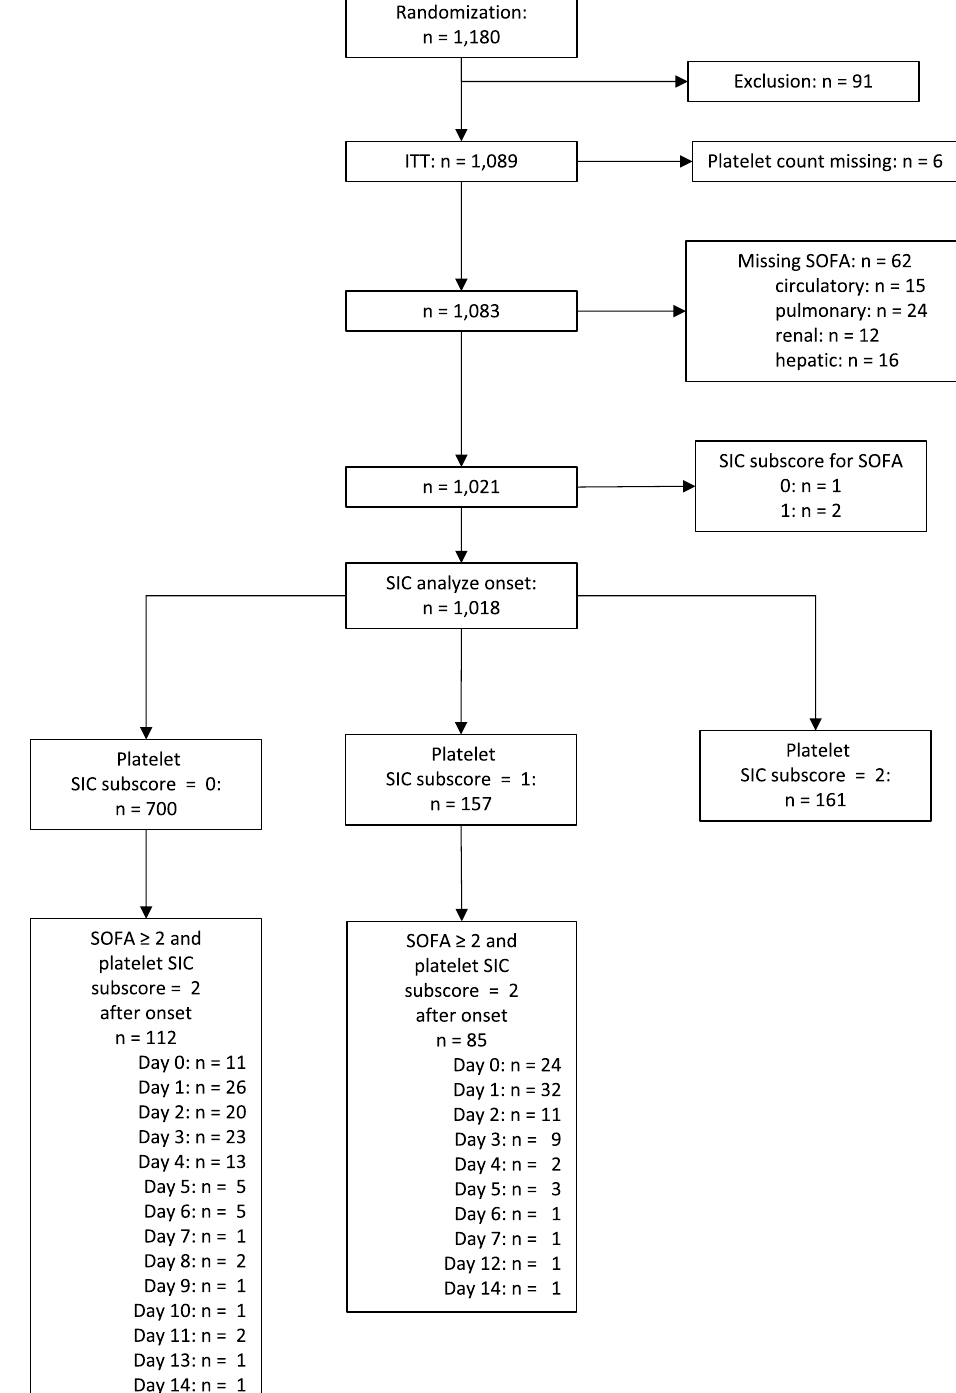
Fig. 3 Flow diagram detailing the selection of patient groups analyzed from the SISPCT trial [15]. ITT intention to treat, SIC sepsis-induced coagulopathy; SOFA Sequential (sepsis-related) Organ Failure